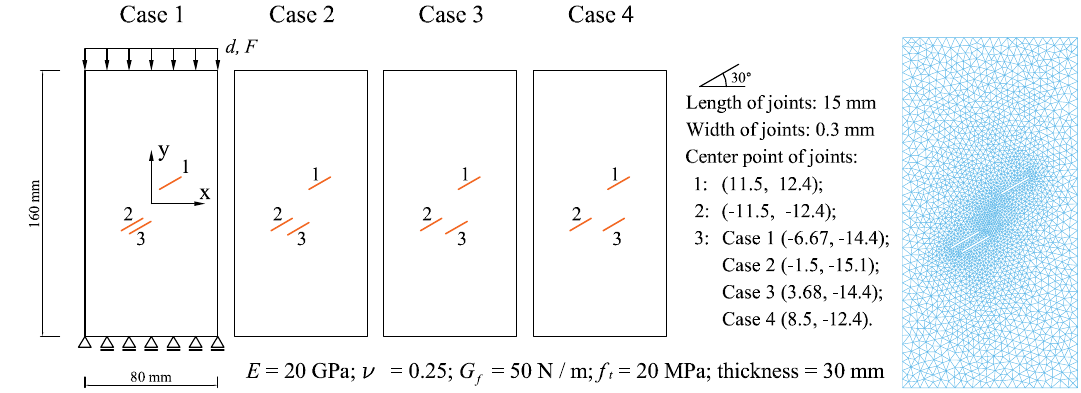
Figure 5. Sandstone containing three pre-existing fissures: the model, material, and